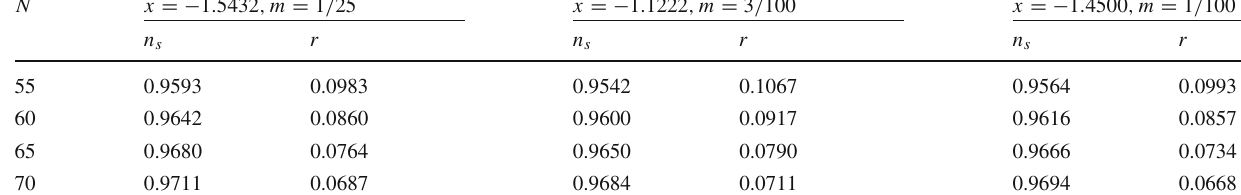
Table 4 For q = 1 and n = 2, Inflationary observables for the different choices of the potential parameters ( x and m ) with variety of total number of e-folds